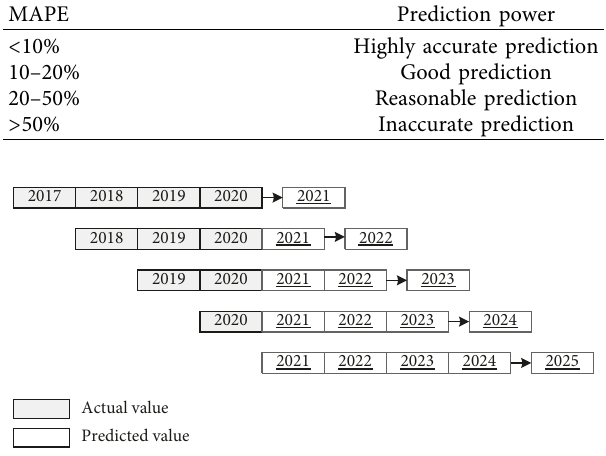
Figure 1: A schematic diagram of the rolling framework.